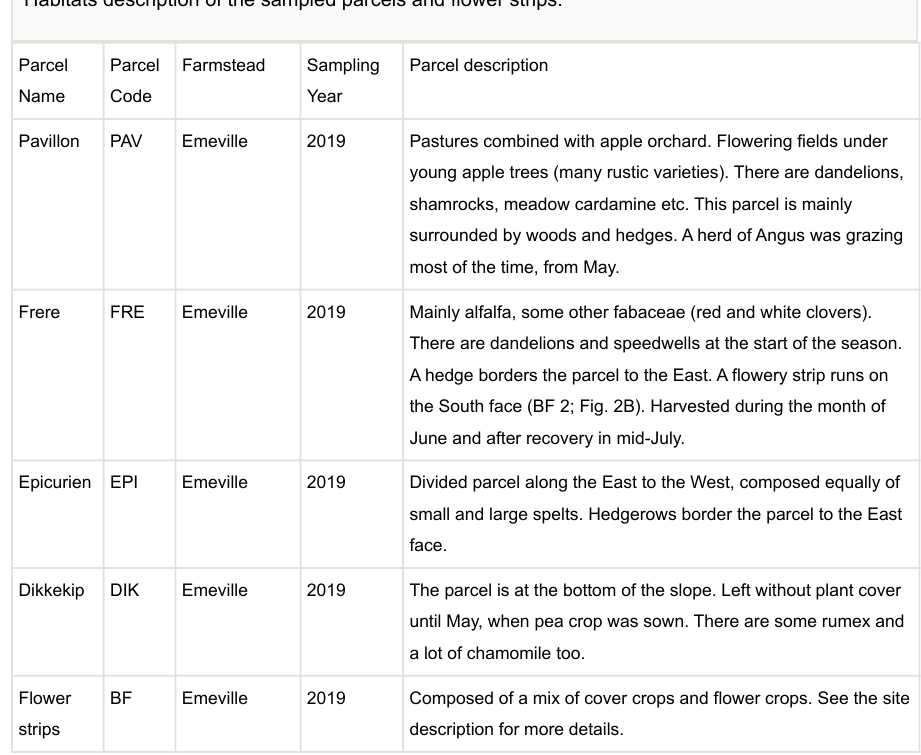
Habitats description of the sampled parcels and flower